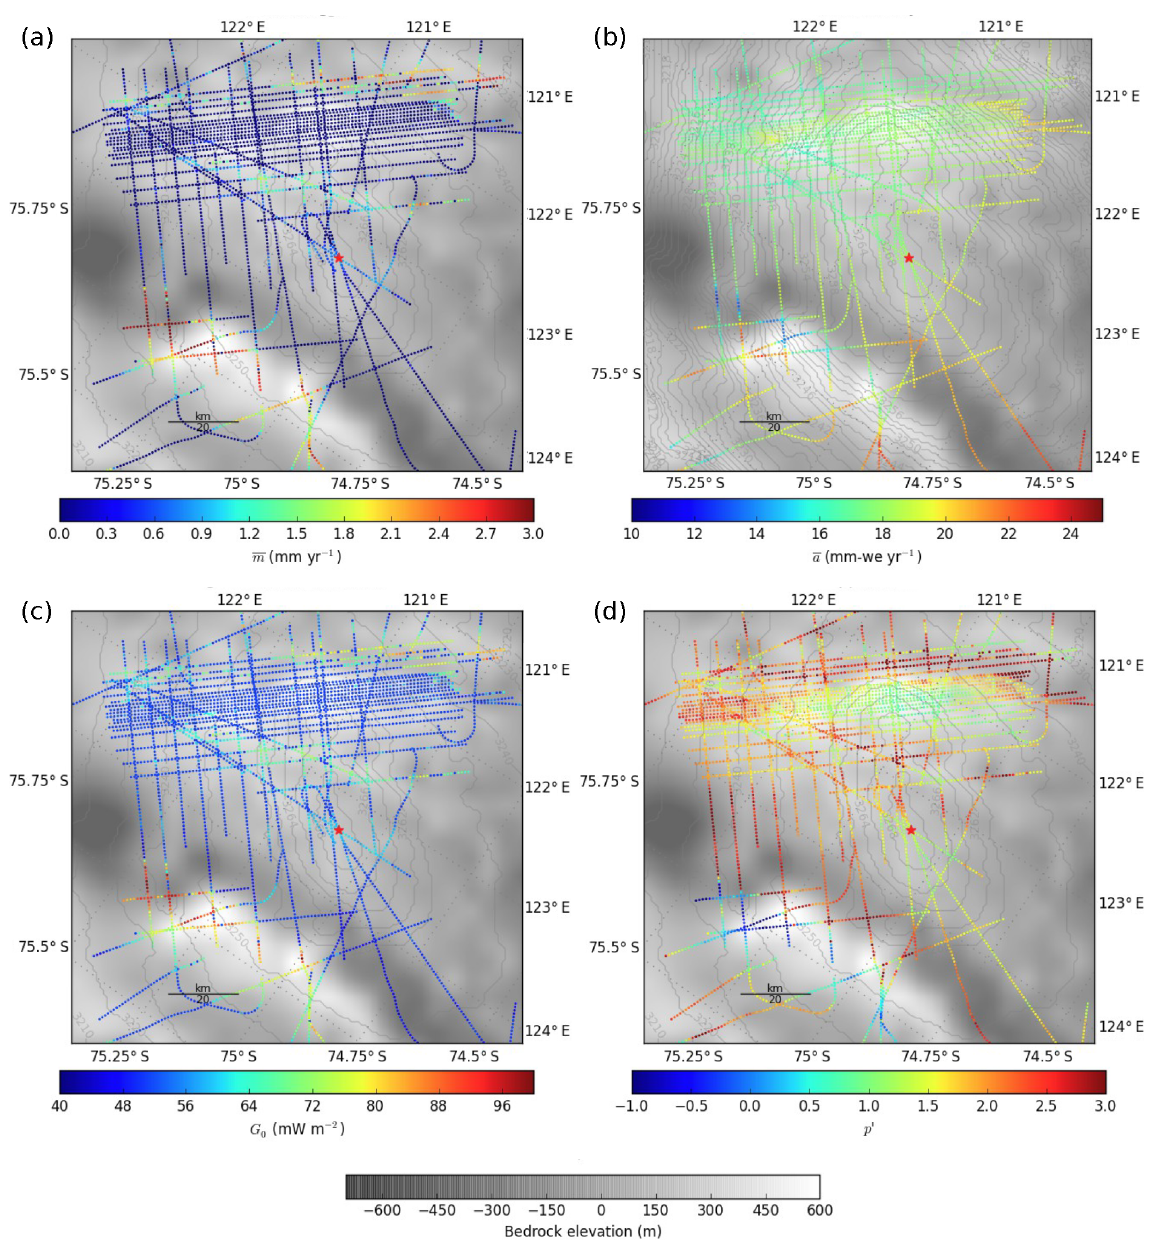
Figure 5. Various variables reconstructed by the inverse method along the radar transects, in vivid colour scale. The bedrock and surface ele- vations (greyscale and isolines respectively) are shown as in Fig. 1. (a) Modelled temporally averaged basal melting. (b) Inferred temporally averaged surface accumulation rate. (c) Inferred geothermal flux. (d) Inferred p (cid:48) vertical velocity